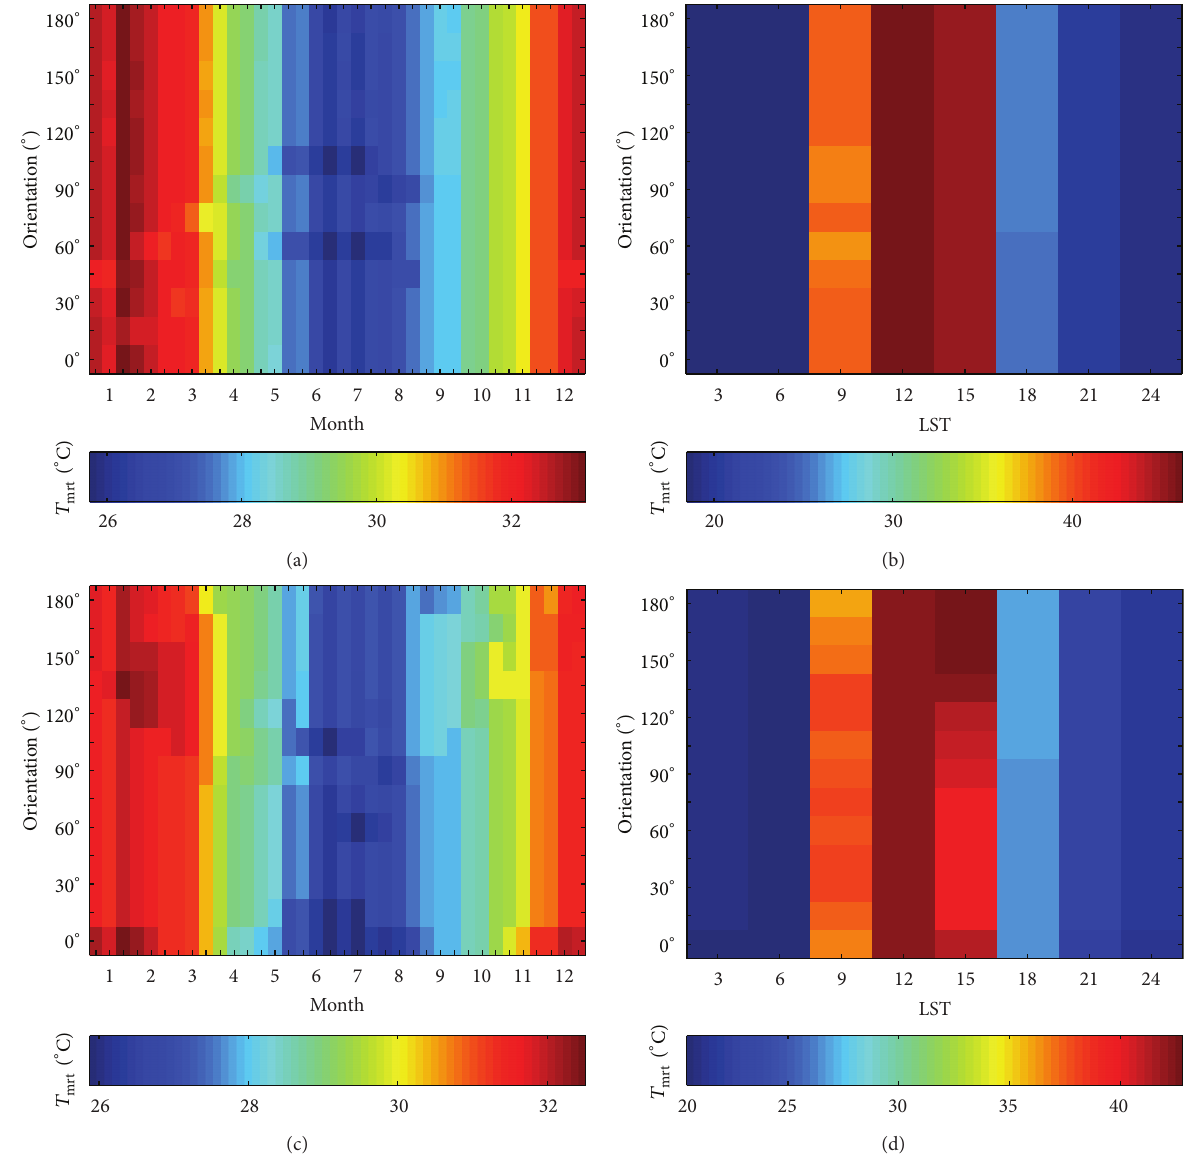
Figure 9: Effects of orientation on the temporal distribution of 𝑇 buildings’ height kept at 5 m. Corresponding effect when buildings’ height was increased to 100m high ((c) and